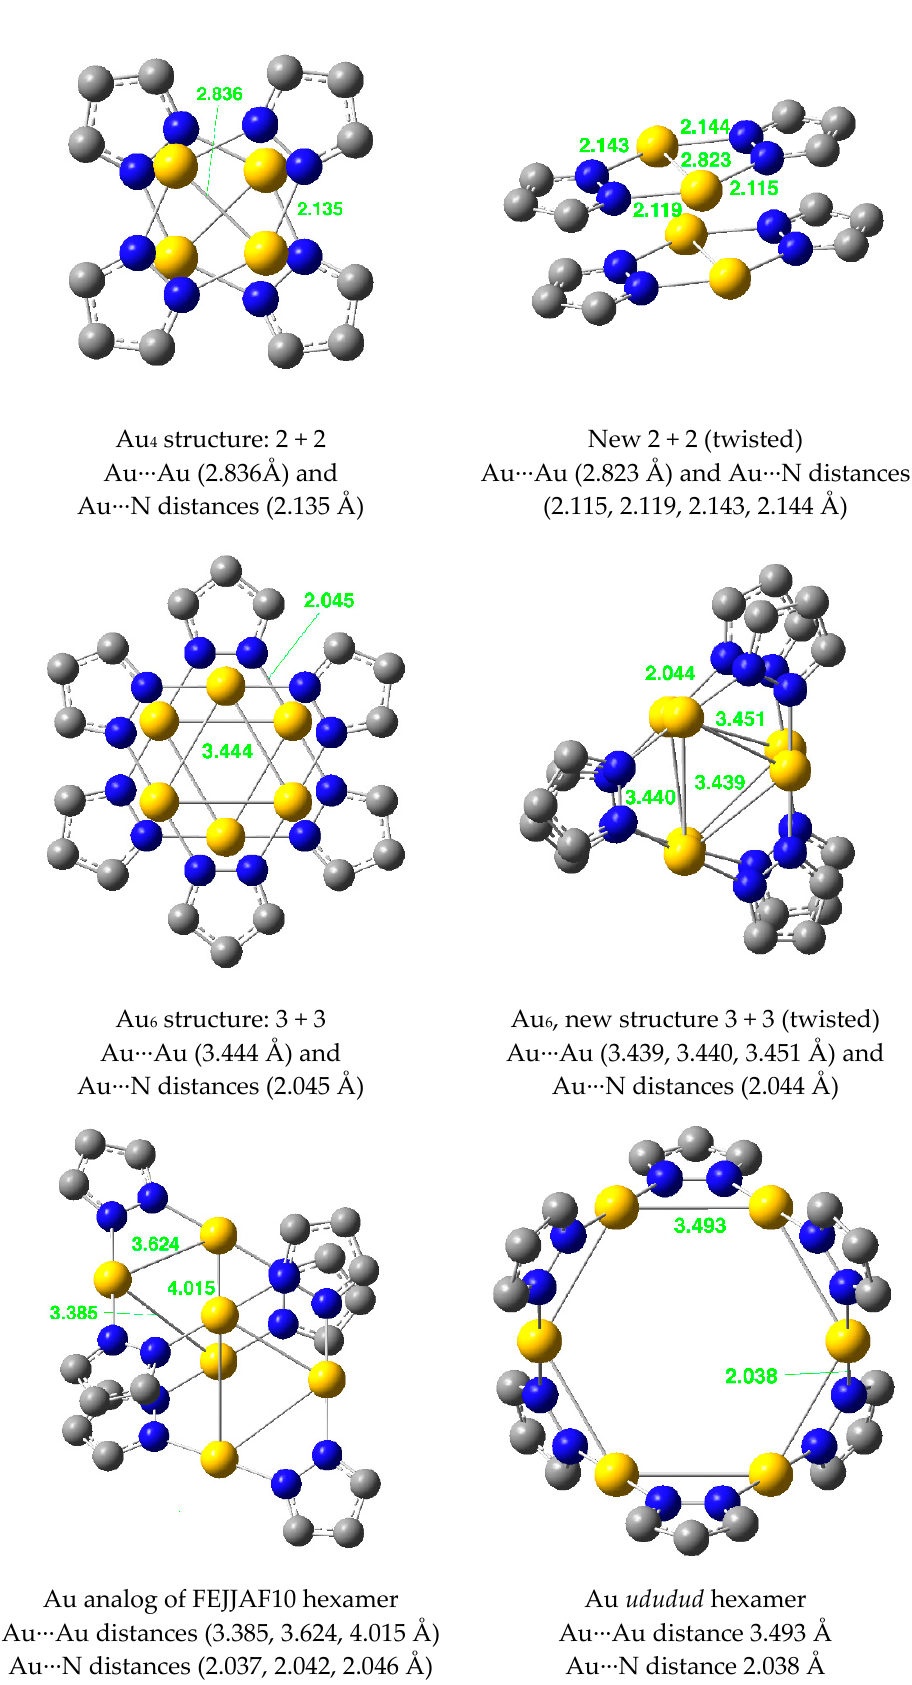
Figure 17. Optimized structures of Au(I) pyrazolates.